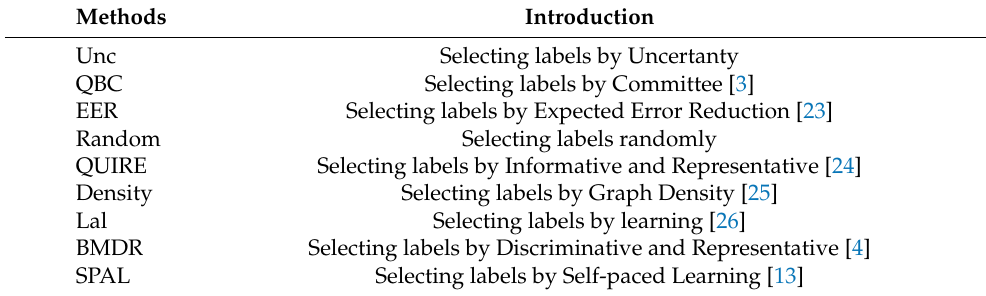
Table 2. Training